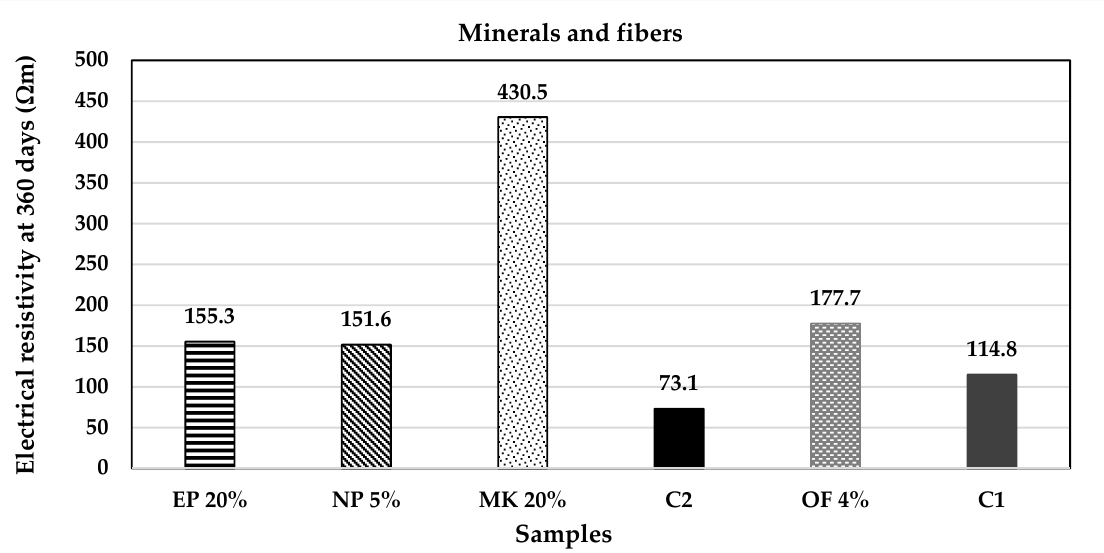
Figure 18. Electrical resistivity of the mineral and fibres group of additions. According to the elemental composition of samples and the pozzolanic activity, SBA, MK and EP react with the alkalis of the cement pastes, while Ca(OH) 2 , NaOH and